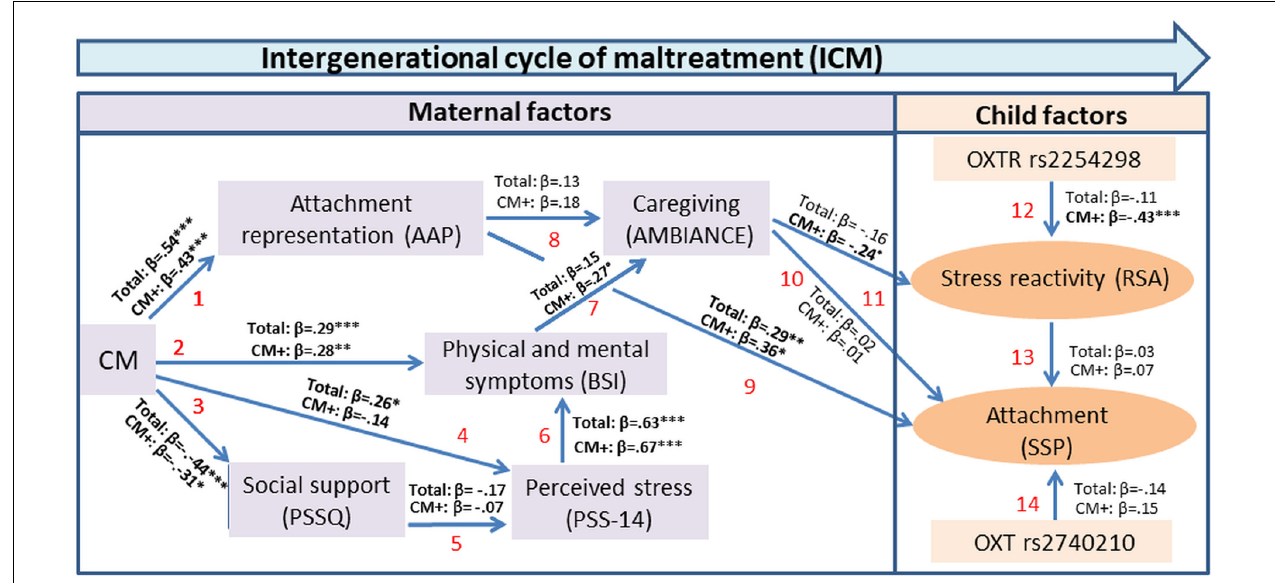
FIGURE 3 | Extended empirical pathway ICM model based on the theoretical model for the intergenerational transmission of attachment by van IJzendoorn and Bakermans-Kranenburg (2019) shown in Figure 1